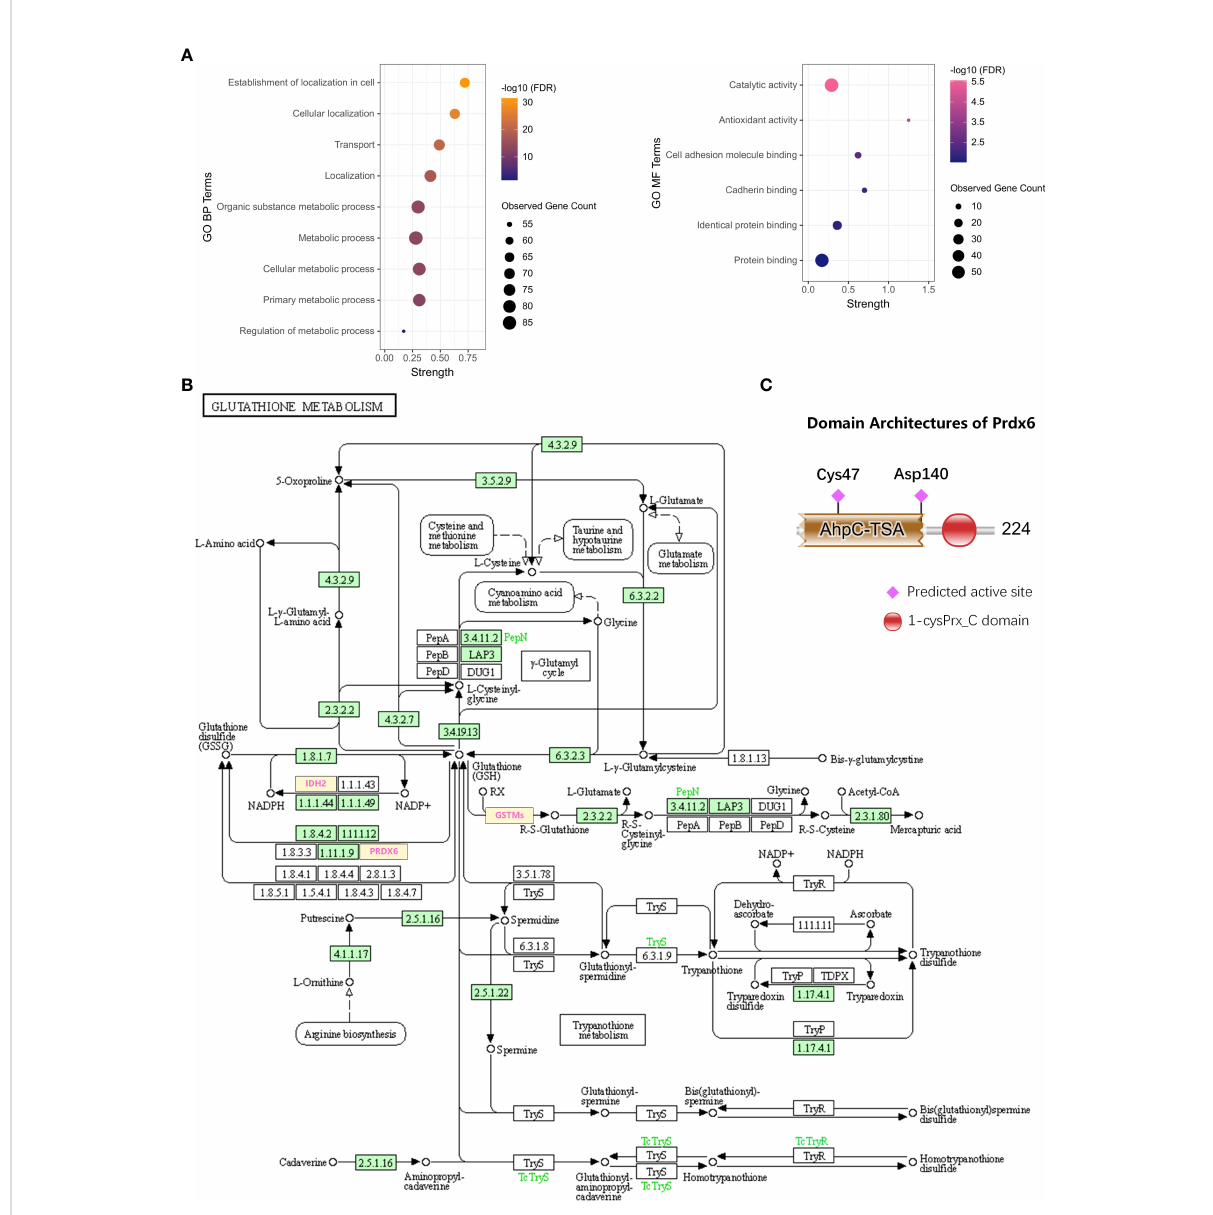
FIGURE 4 The biological function of PRDX6. (A) The bubble plots show the BP and MF terms of GO functional enrichment including PRDX6. (B) The DRG proteins of GSTM2, GSTM5, GSTM1, IDH2, and PRDX6 participate in the KEGG pathway of Glutathione metabolism (hsa00480). (C) The domain analysis and visualization were performed by the HMMER database. The architecture of PRDX6 protein shows the two domains of AhpC-TSA and 1-cysPrx_C, and there are two active sites of Cys47 and Asp140 in AhpC-TSA. BP, Biological Process; MF, Molecular Function; KEGG, Kyoto Encyclopedia of Genes and Genomes. Asp,